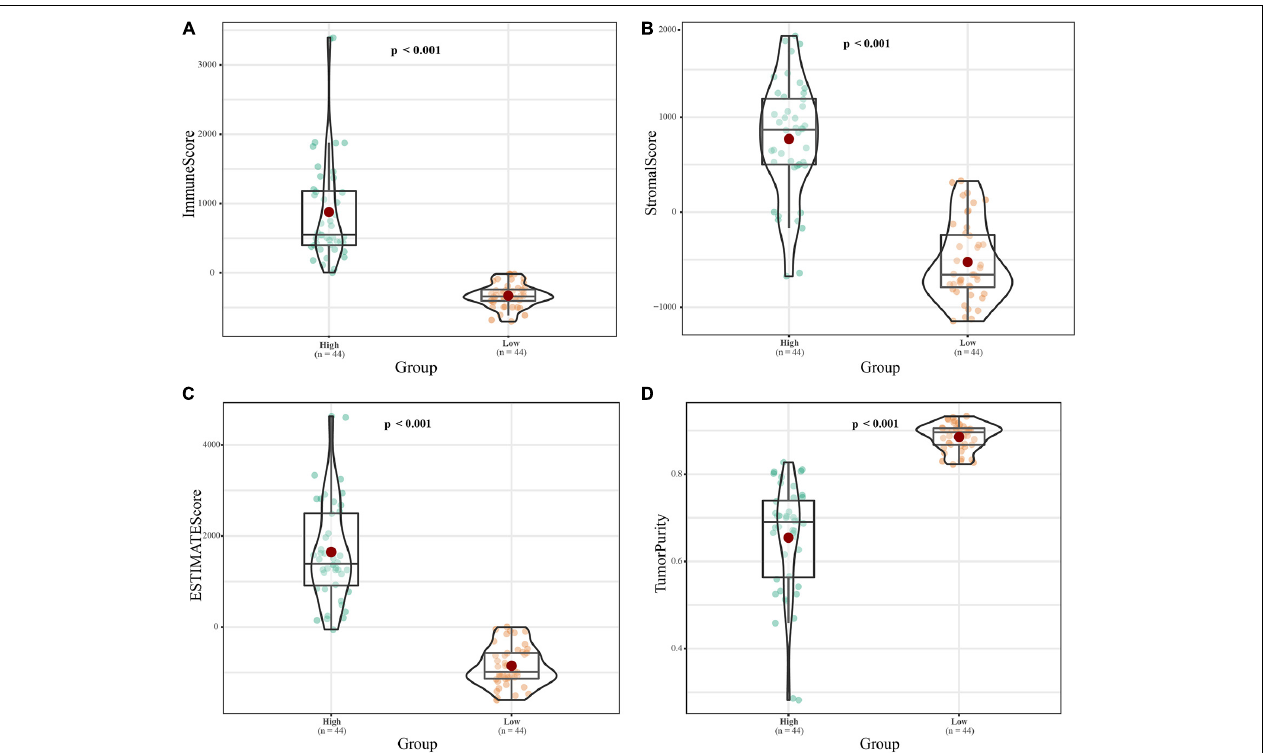
FIGURE 1 | Classification of 88 ES samples based on immune score. (A) Box plot of the immune scores of the high- and low-risk groups. (B) Box plot of stromal scores. (C) Box plot of ESTIMATE scores. (D) Box diagram of tumor purity.